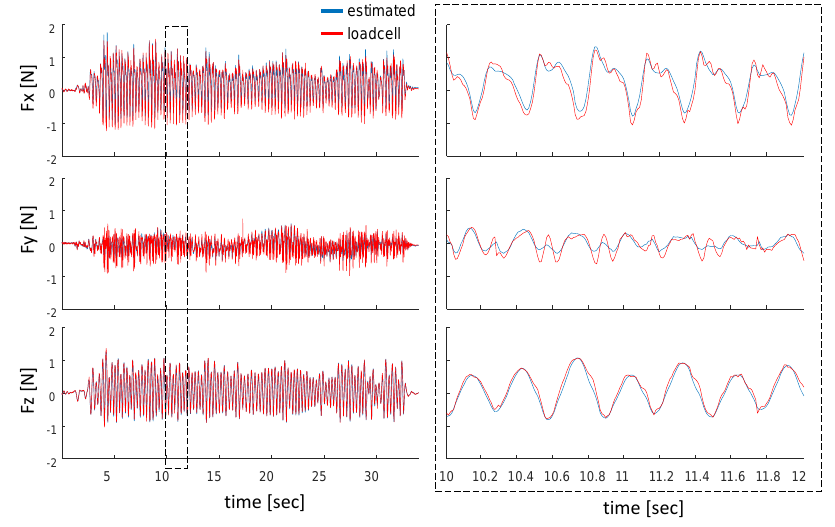
Figure 7. Component-wise comparison of forces as measured from the loadcell and non-inertial forces as estimated through IMU accelerations.